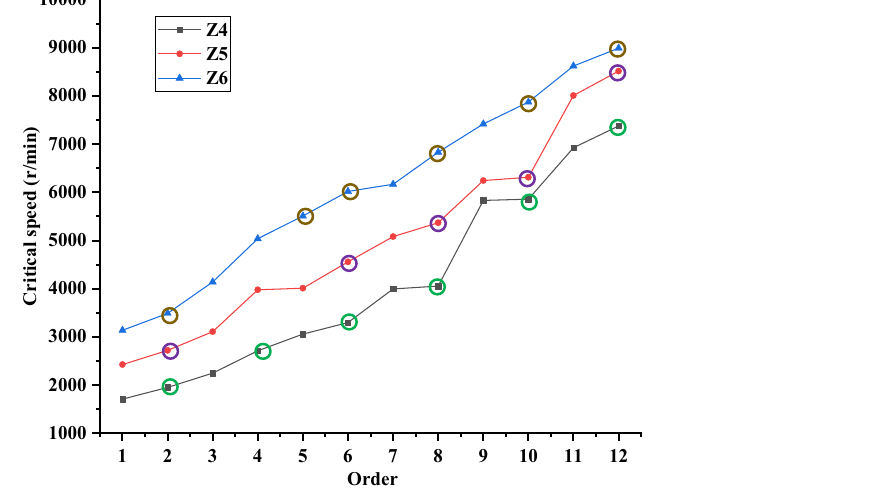
Figure 17. Comparison of the critical speeds on three